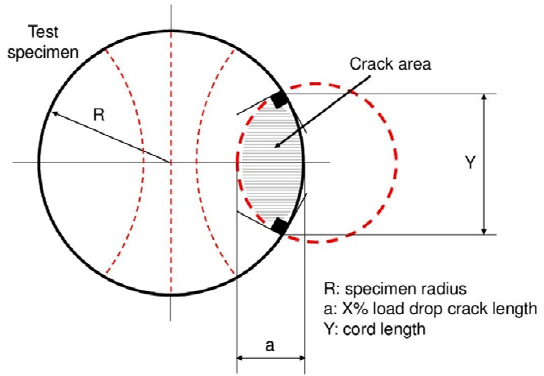
Figure 4. Overlapping circles model, adapted form [27], and development of the crack shape in cylindrical specimens.